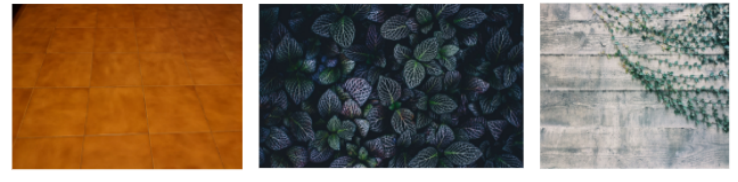
Figure 4. Background samples.